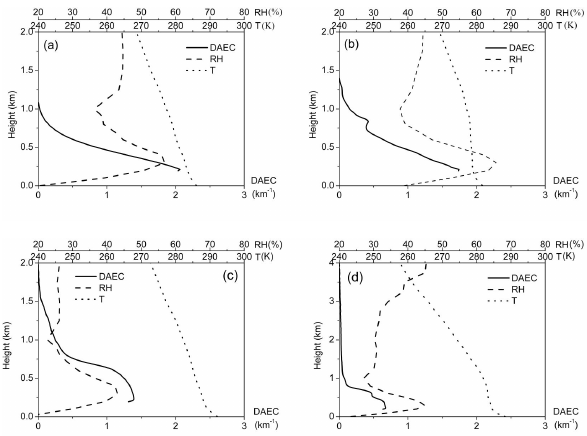
Fig. 10. Vertical profiles of dust aerosol extinction coefficient (DAEC), relative humidity (RH), and temperature ( T ) at (a) 23:00 (Beijing Time), 27 March, (b) 04:48, 28 March, (c) 14:57, 28 March, and (d) 11:15, 29 March 2007. DAEC and RH showed similar variation trends.